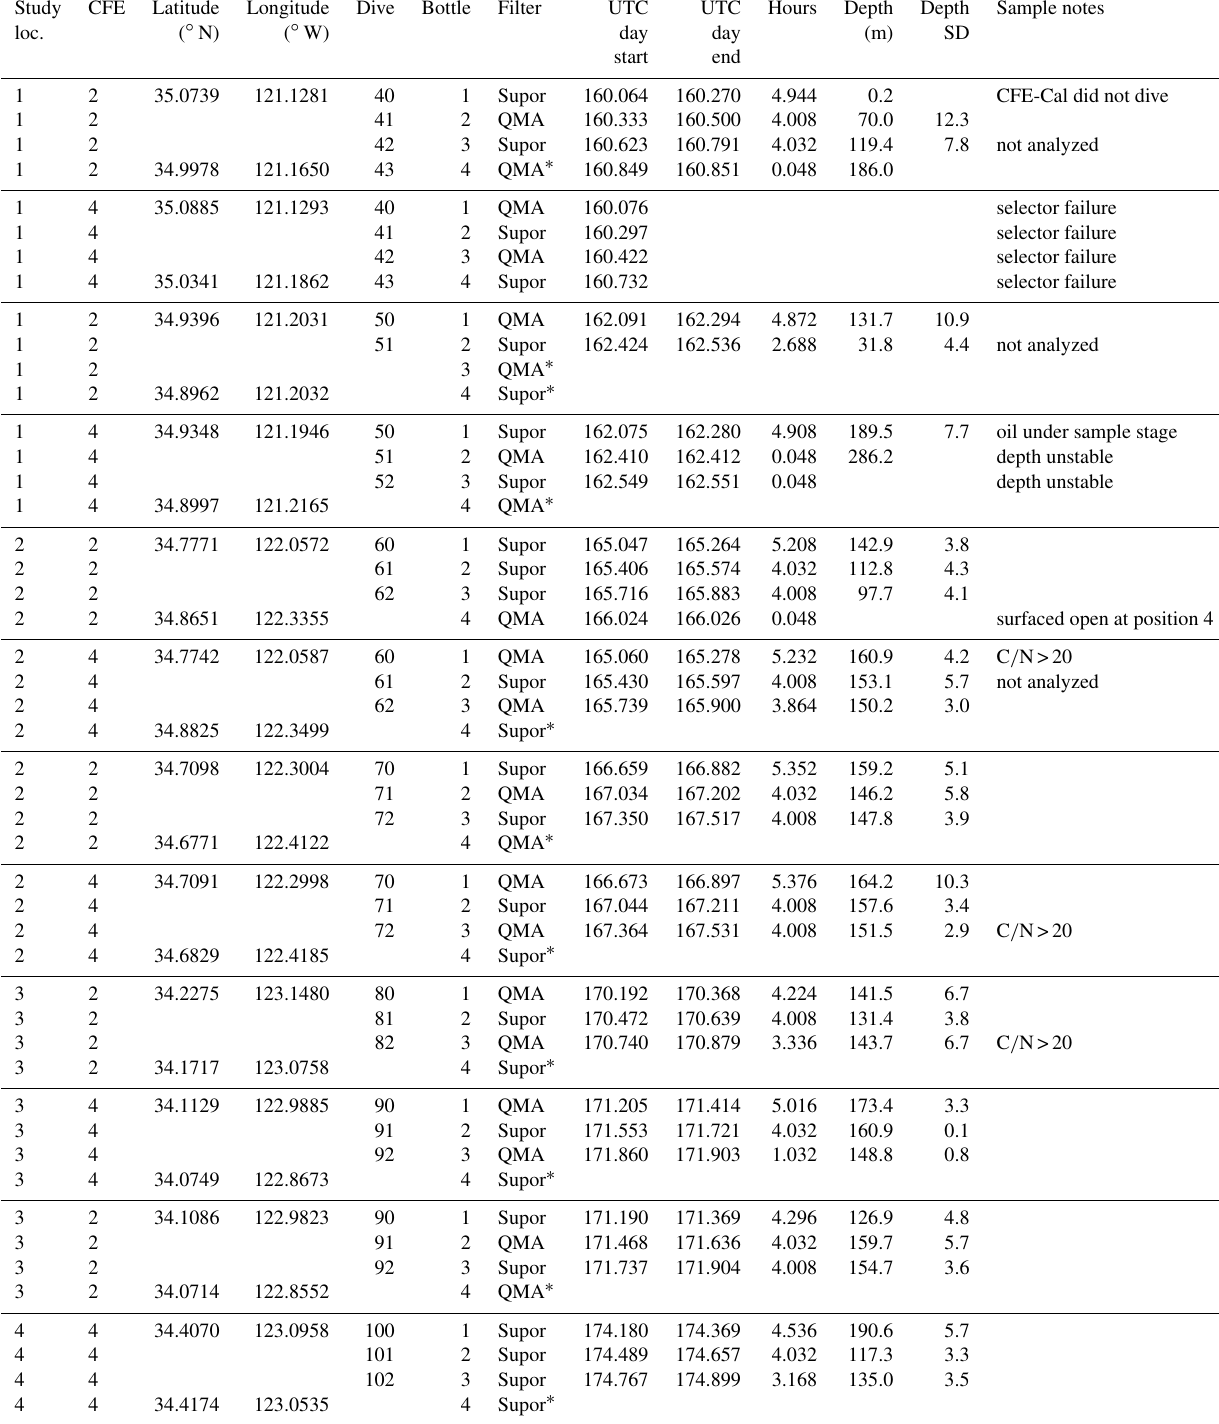
Table 1. CFE-Cal 2017 deployments during the California Current Ecosystem Long-Term Ecological Research process study. This table notes the location number, CFE number, longitude and latitude position, dive number, bottle number, filter type, sampling interval and depth interval of sampling. Filters marked with the ∗ symbol are process blanks. The note column indicates any sample notes, including any instrument malfunctions. UTC day: days since 00:00 on 1 January; noon on 1 January: UTC day